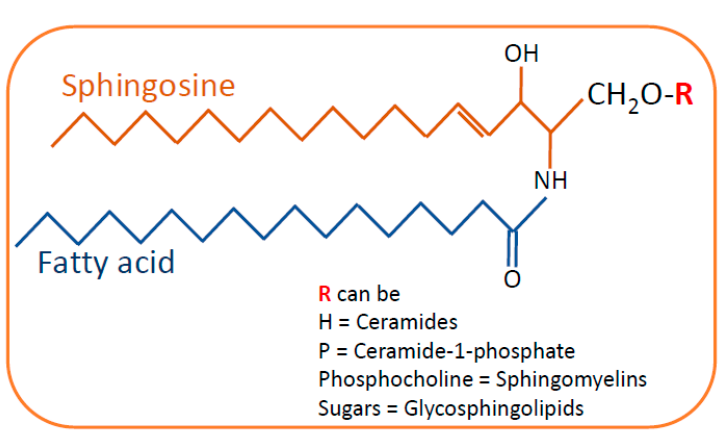
Figure 1. General structure of sphingolipids. Sphingosine is the backbone of the sphingolipid structure that is linked to fatty acids by an amide bond. Depending on the type of residue in the side chain, sphingolipids are categorized as ceramides, sphingomyelins and